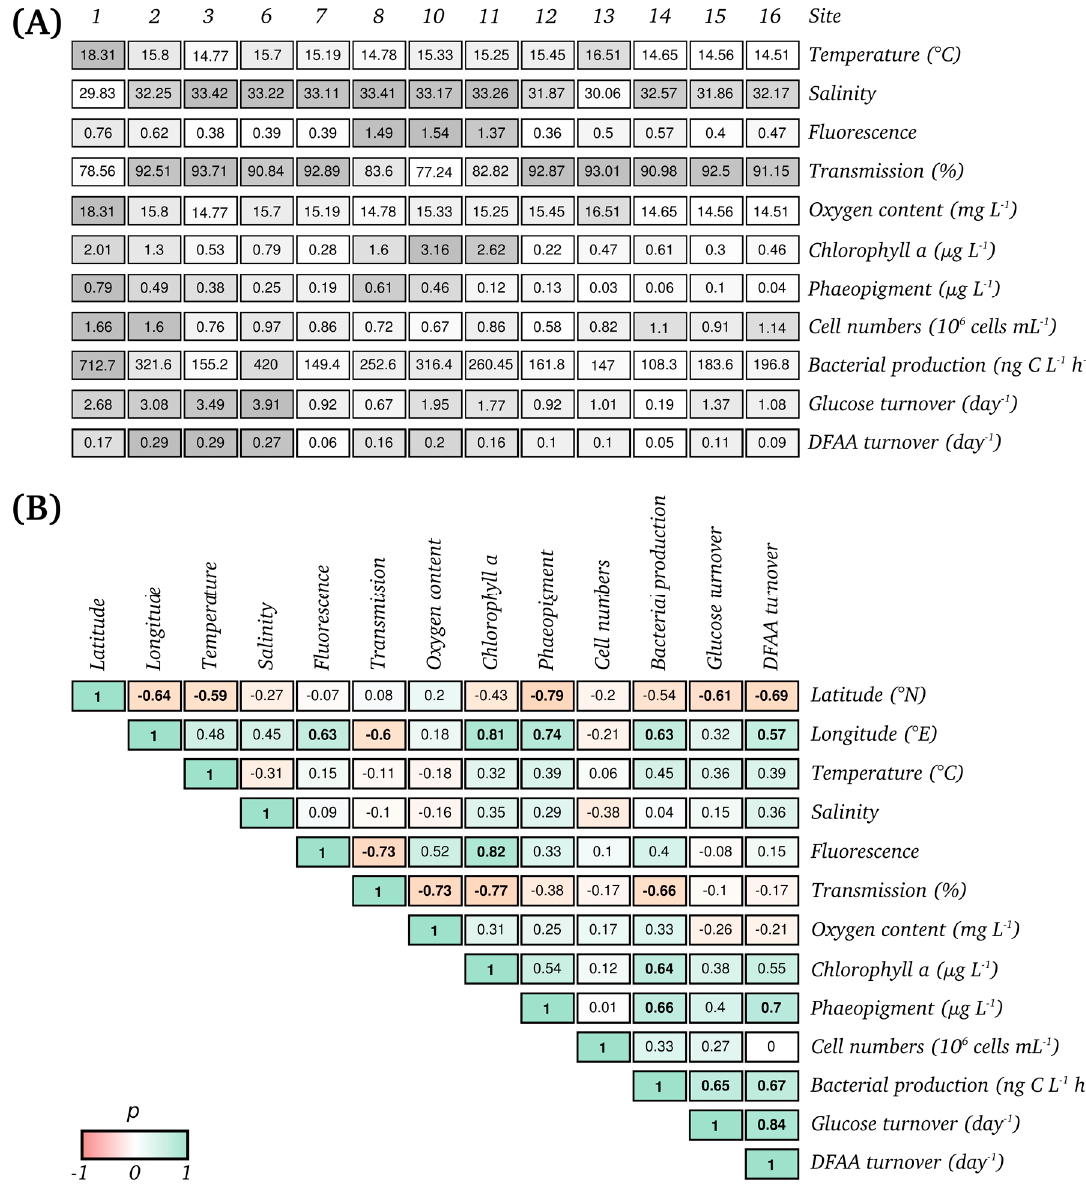
Figure 2. Environmental and microbial properties measured along the transect ( A ) and pairwise Spearman’s rank correlations between these properties ( B ). The shading in ( A ) accentuates the differences of environmental and microbial properties at each site (white to grey = lowest to highest value measured).